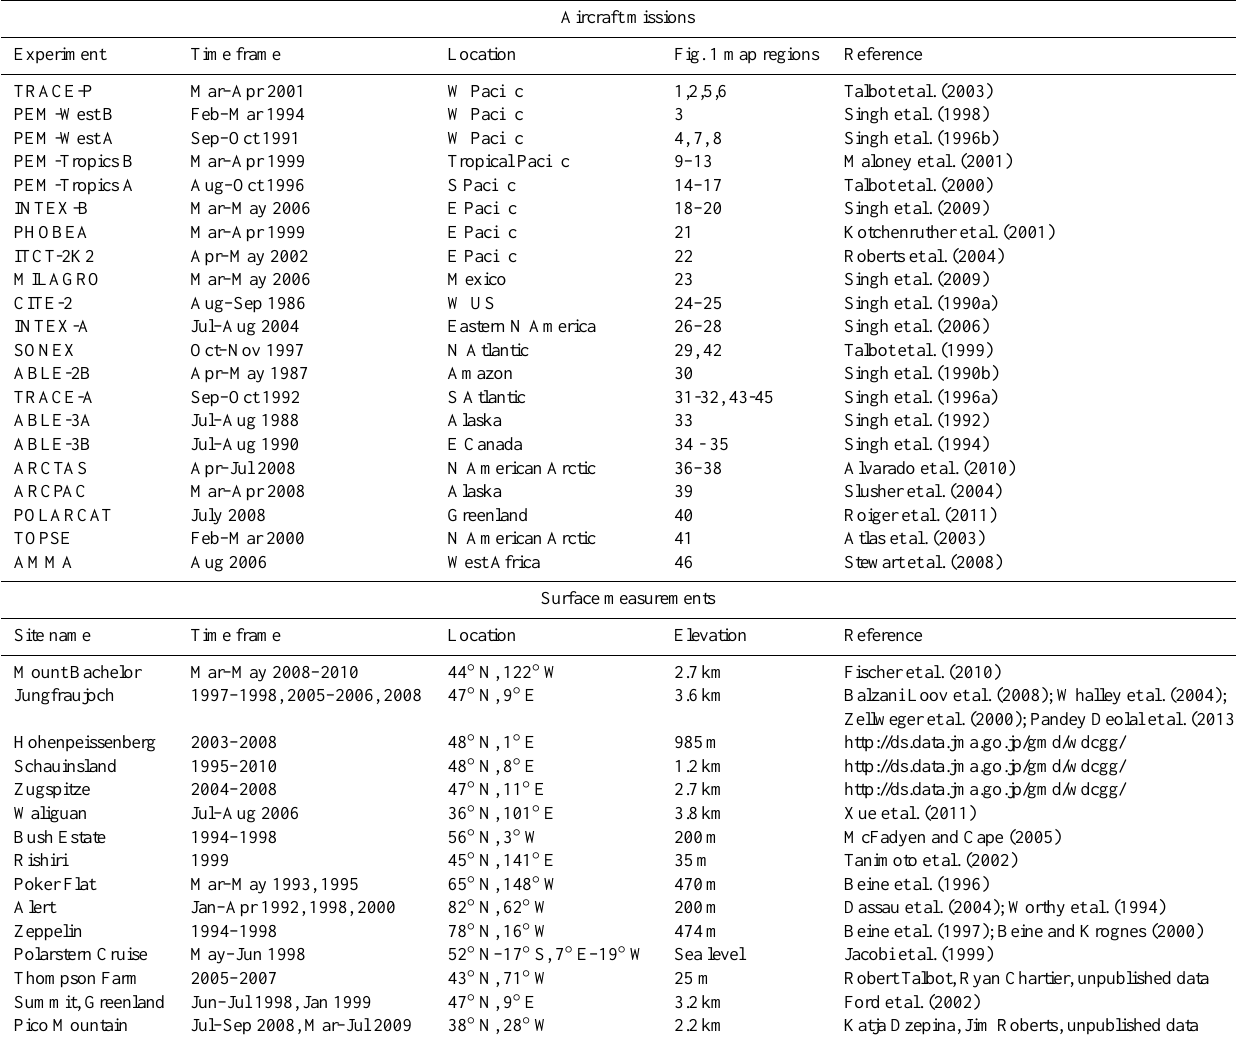
Table 2. Global PAN measurements used for model evaluation listed in order of map regions labeled in Fig. 2.